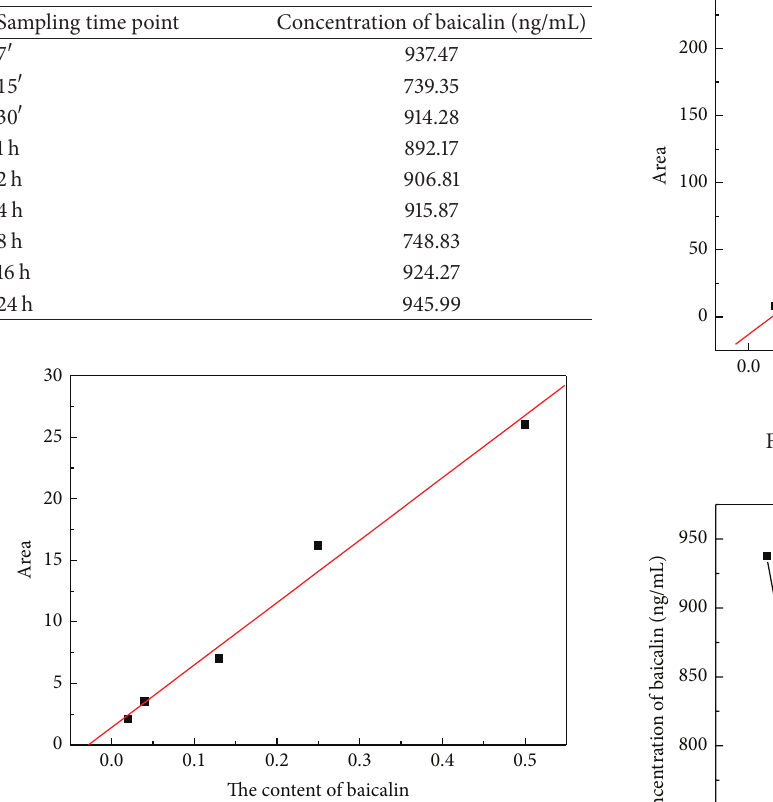
Table 3: Blood concentrations of baicalin—schedule.